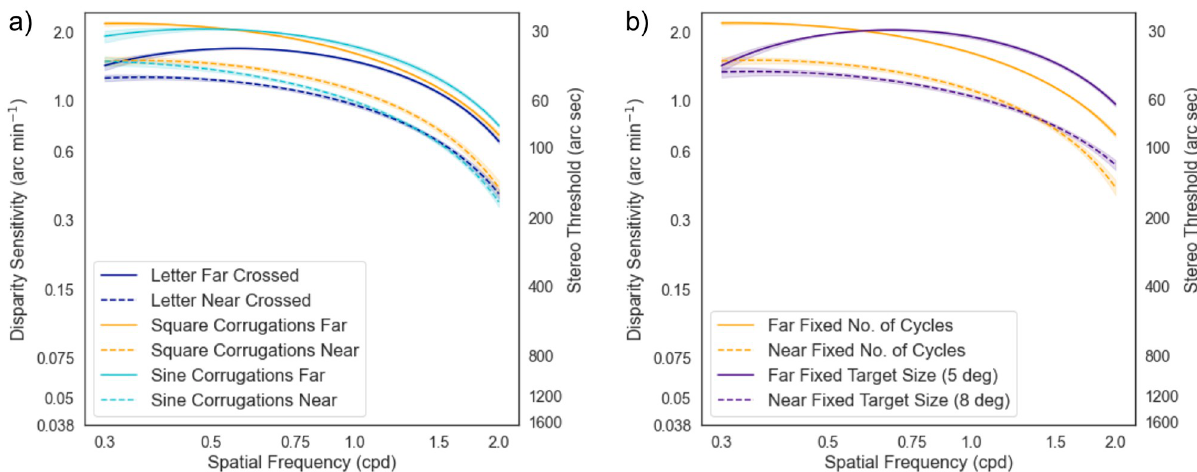
Fig 7. Comparison between stereo letter and gratings corrugations. a) Stereo sensitivity with letter targets were lower than square and sine corrugations at the low spatial frequencies range. The sensitivity at high spatial frequencies is comparable between letters and gratings corrugations. b) The DSF curves between the fixed target size and fixed number of cycles with square wave corrugations are relatively similar. However, at high SFs, the sensitivity was slightly better when a greater number of cycles were added in a fixed target size. The shaded region denotes the 95% confidence interval from bootstrap resampling (1000